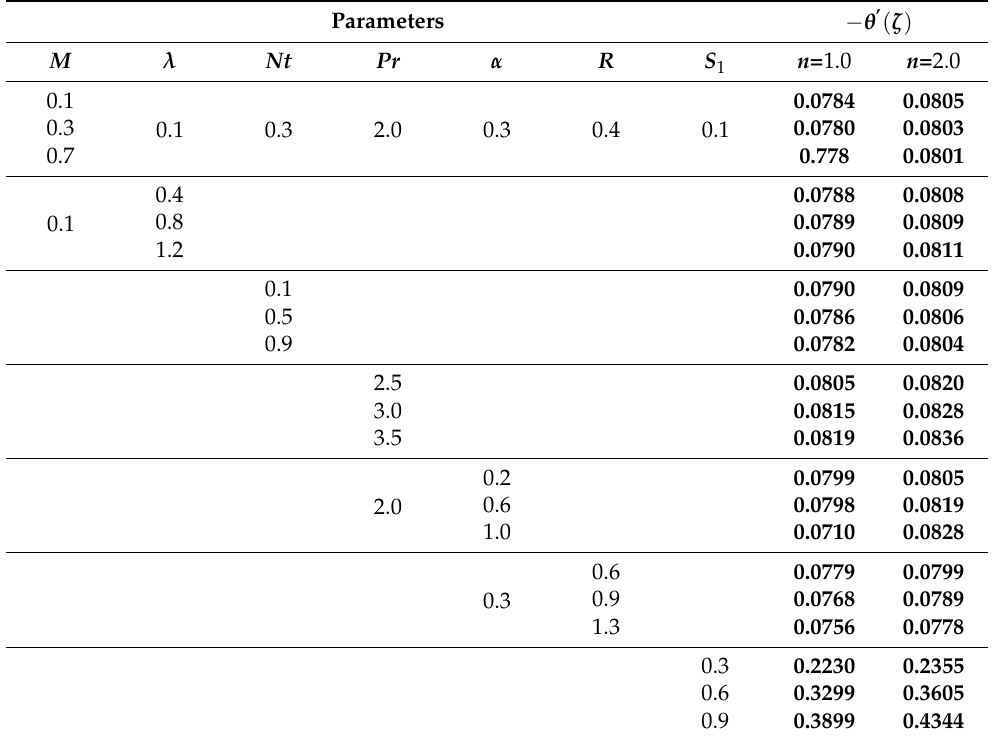
Table 3. Effect of flow factors over local Nusselt number − θ (cid:48) ( ζ ) at ζ = 0.